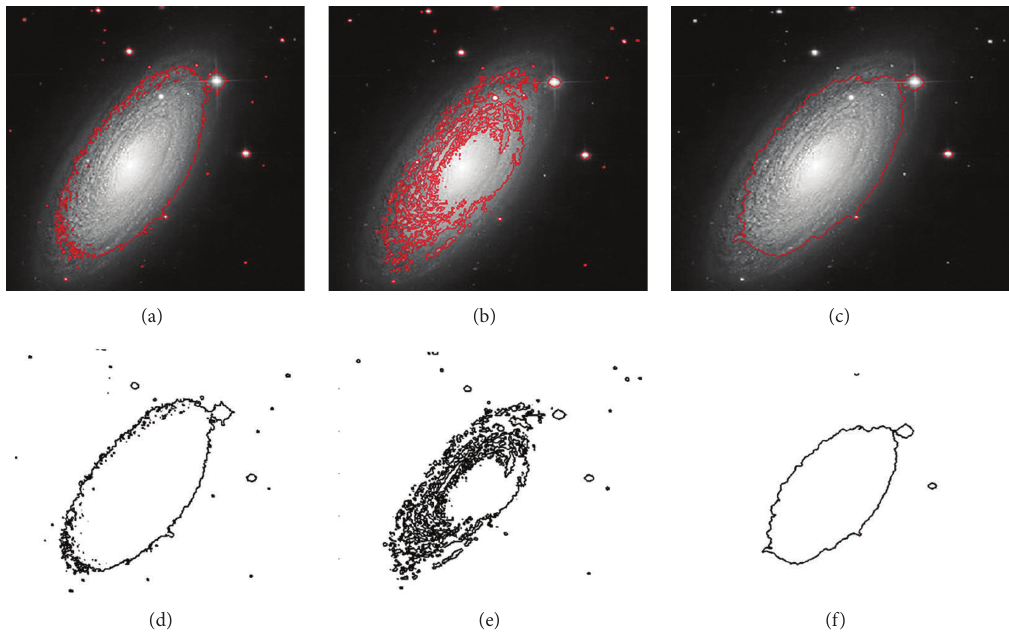
Figure 3: The segmentation results of the natural image: (a) and (d) results using CV model, (b) and (e) results using LBF model, and (c) and (f) results using the new